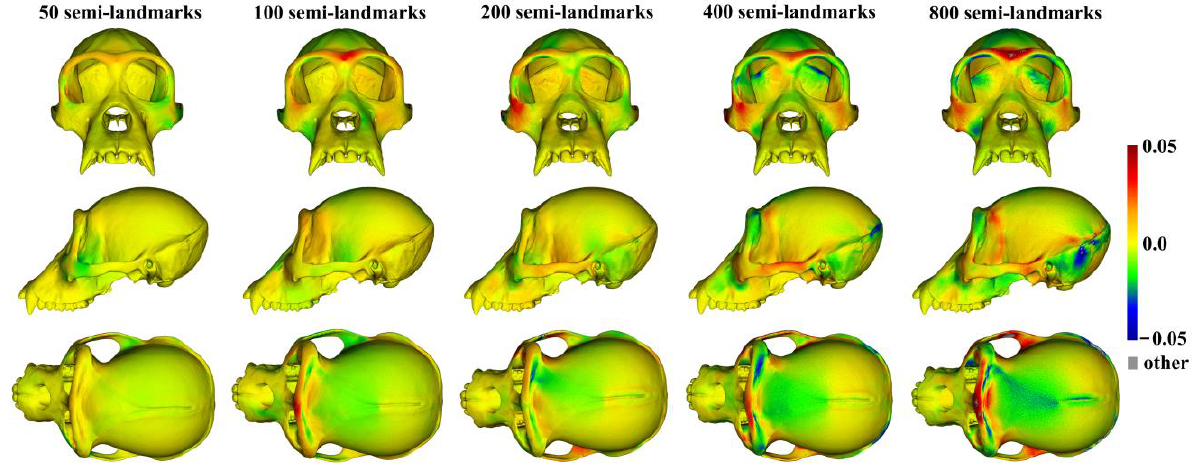
Figure 9. Visualization of the regional differences in local surface areas of mean ape cranial shapes from sliding TPS (reference) and TPS&NICP (target) approaches. Scale bar indicates difference in local area between reference and target surfaces expressed as a proportion of the reference